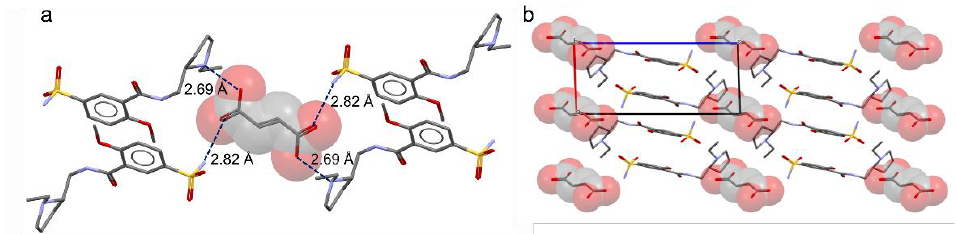
Figure 3. ( a ) Intermolecular interactions established between fumarate and the surrounding hydro- genated SULP molecules (dashed blue lines). ESDs are omitted for the sake of clarity. ( b ) Crystal packing of SULP-FA along the (010) direction. Color code C = grey, N = blue, O = red, S = yellow. FA ions are highlighted with spacefill style shadow. Hydrogen atoms are omitted for the sake of clarity.